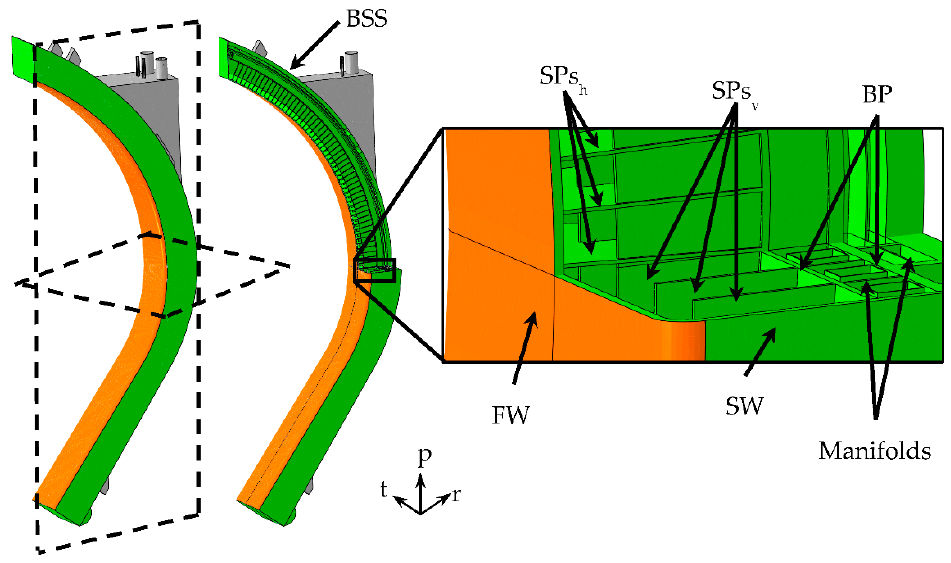
Figure 2. COB Segment architecture and detail of the main